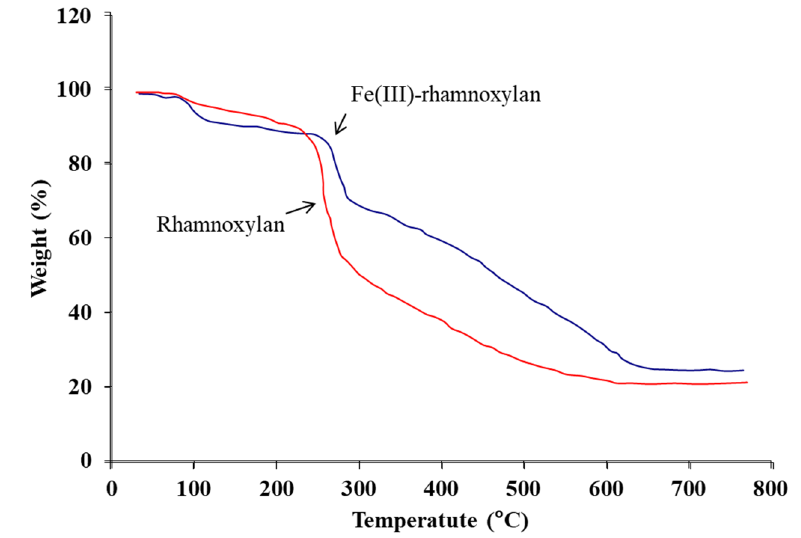
Figure 9. TGA curves of rhamnoxylan and Fe(III) ‐ rhamnoxylan recorded at 10 °C min − 1 under nitrogen flow (30 mL min − 1 ).